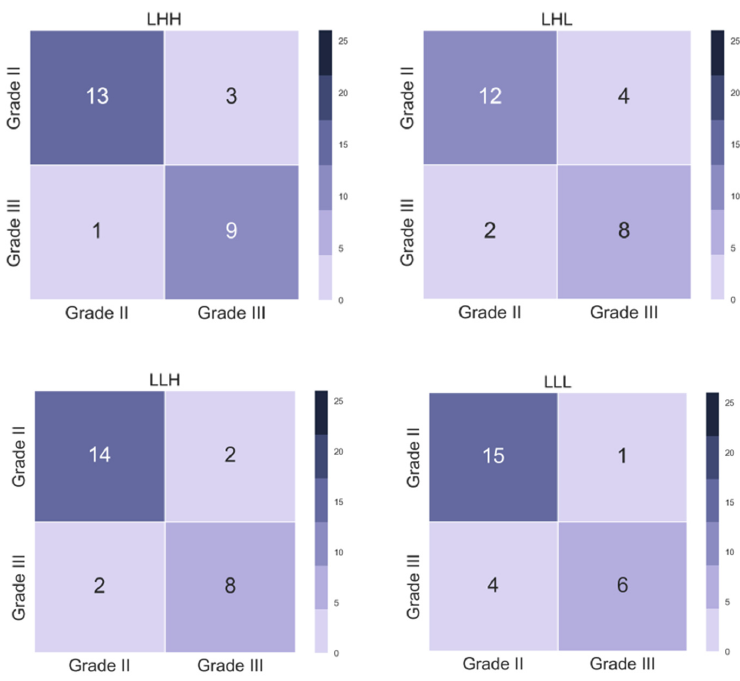
Figure 5. Confusion matrices of all wavelet sub-bands.